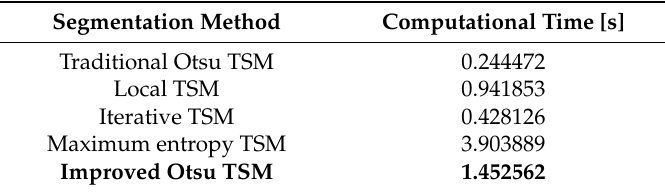
Table 9. Computational costs of different segmentation methods on Figure